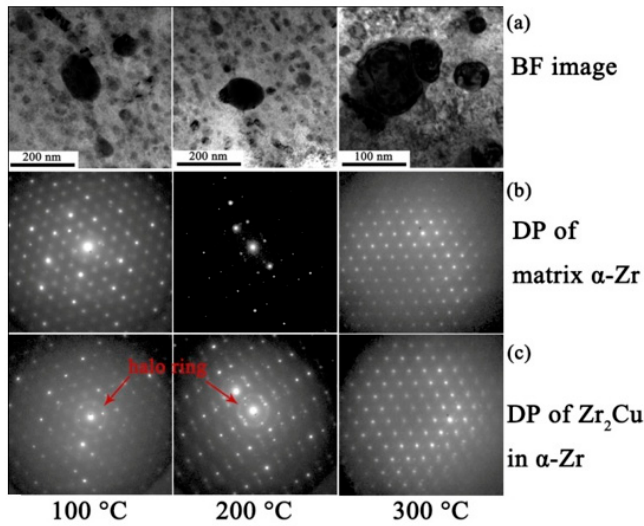
Figure 6. The ( a ) bright field images, ( b ) selective area diffraction patterns of α –Zr grains, and ( c ) Zr 2 Cu in α –Zr at 100 °C, 200 °C, and 300 °C after irradiation showing the amorphous transformation in Zr 2 Cu under heavy ion irradiation to 10 dpa. The diffraction patterns were taken at z (zone axis) = [0002] of α –Zr.